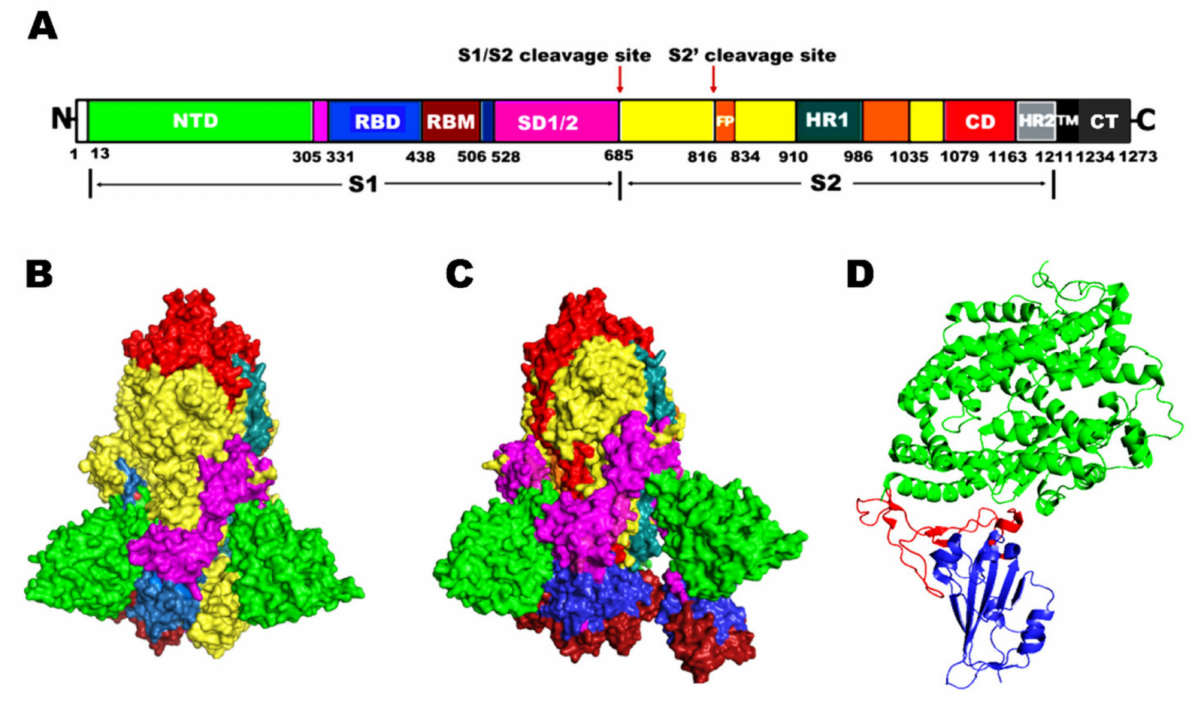
Figure 1. ( A ) Schematic representation of the domains arranged in the structure of the SARS-CoV-2 Spike protein. Different domains that constitute the protein are color-coded. NTD, N-terminal domain; RBD, Receptor binding domain; RBM, Receptor binding motif; SD1/2, Subdomain 1 and 2; S1/S2, protease cleavage sites S1 and S2; FP, Fusion peptide; HR1, Heptad repeat 1; CH, Central helix; CD, Connector domain; HR2, Heptad repeat 2; TM, Transmembrane domain; CT, Cytoplasmic tail. The protease cleavage (polybasic) sites located at the interface of S1 and S2 subunits are indicated by arrows, wherein the viral and host cell membrane fusion takes place. ( B ) Cryo-EM structure of the SARS-CoV-2 S glycoprotein homotrimer (PDB: 7DF3) in closed conformation ( C ) Cryo-EM structure of the SARS-CoV-2 S glycoprotein homotrimer (PDB: 7DK3) in open conformation, and ( D ) Secondary structure of S RBD bound to human ACE2 (PDB: 6M0J). Core RBD is shown in blue, RBM in red, and ACE2 in